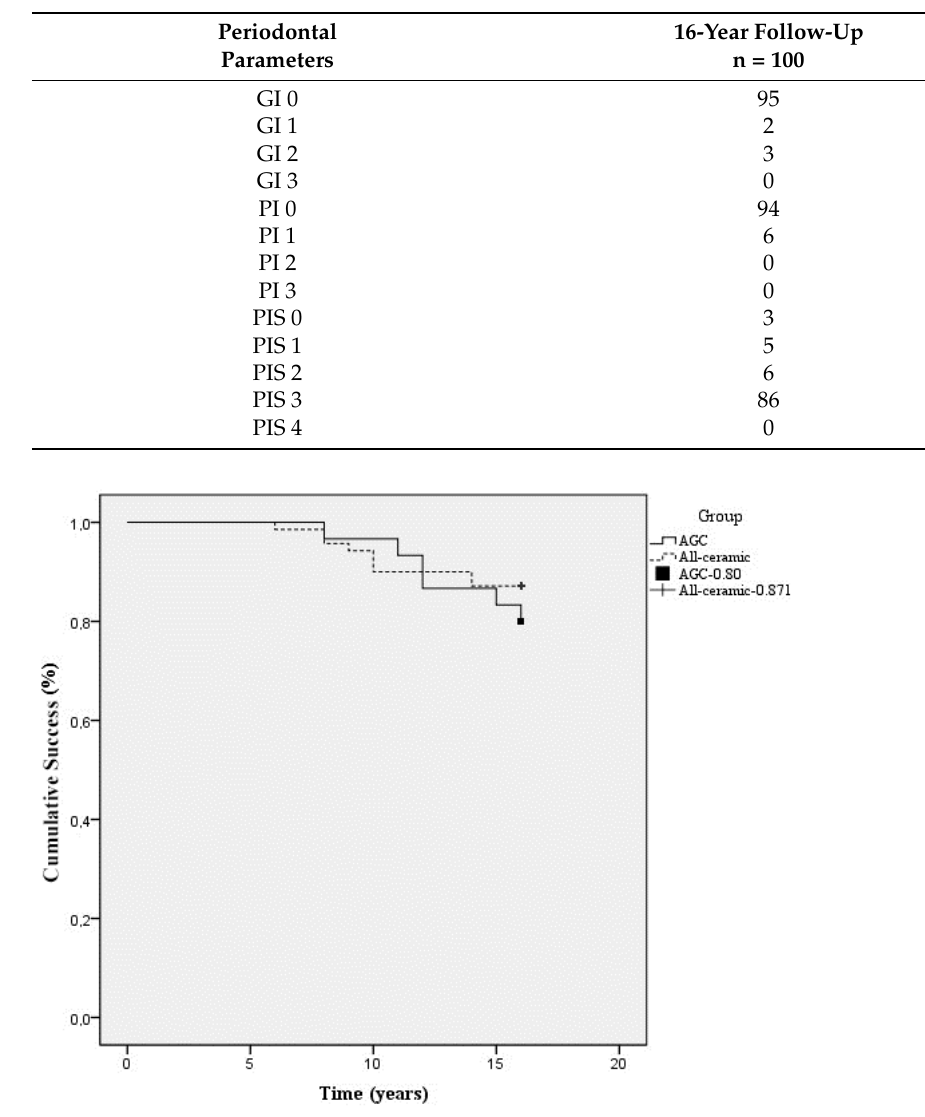
Table 2. Gingival Index (GI) score, Plaque Index (PI) score, and Papilla Index Score (PIS) at 16-year follow-up.